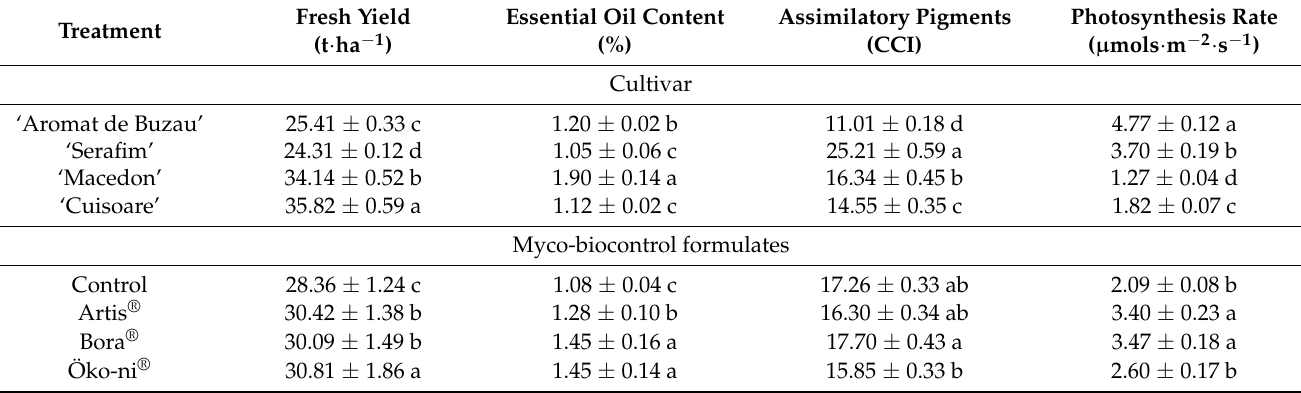
Table 2. Influence of cultivar and myco-biocontrol formulates on fresh yield, essential oil (EO) content, assimilatory pigments and photosynthesis rate of basil.